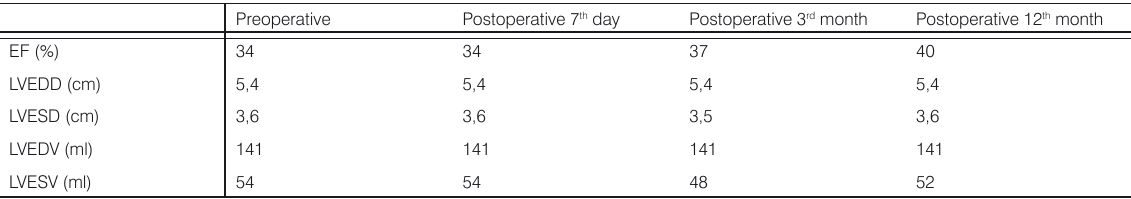
Table 3. Preoperative and postoperative echocardiographic data demonstrating ejection fraction, end-diastolic, and end-systolic diameters and volumes of the left ventricle.